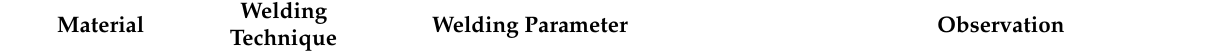
Table 1. Mechanical properties and microstructural features of fusion welded HEA .